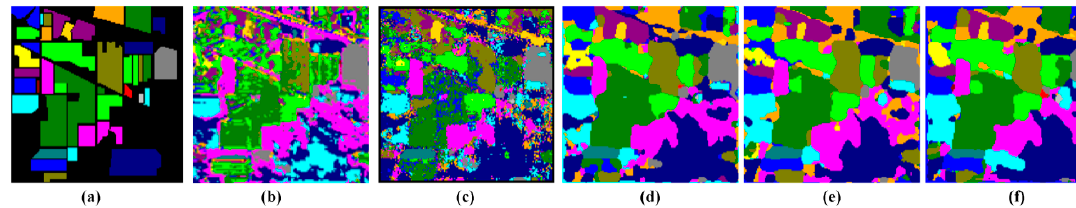
Figure 10. Classification results for the Indian Pines data set obtained using different methods. ( a ) Ground-truth map; ( b ) SAE-LR; ( c ) CNN; ( d ) SSRN; ( e ) FDSSC; and ( f ) AUSSC.